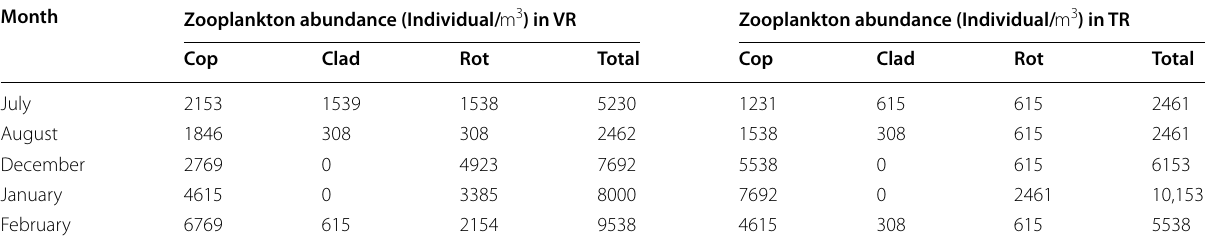
(Cop—Copepoda; Clad—Cladocera; Rot—Rotifera)